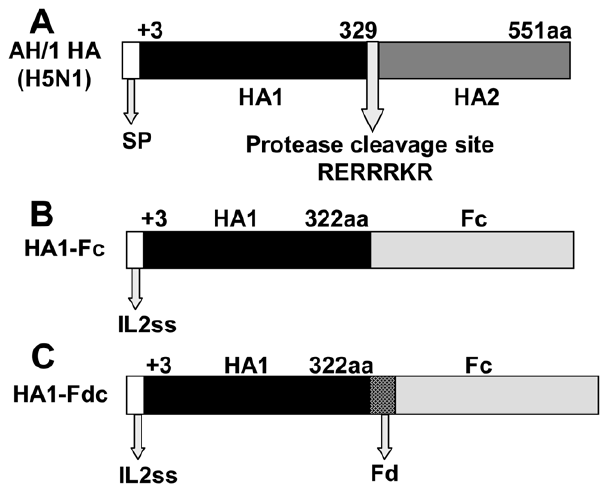
Figure 1. Structure of HA protein of AH/1 and construction of recombinant HA1-Fc and HA1-Fdc proteins. (A) Structure of HA protein of H5N1 AH/1 strain. The HA protein of AH/1 H5N1 virus consists of signal peptide (SP, residues 1–18), HA1 (residues 19–345, corresponding to + 3-329aa) and HA2 (residues 346–567, corresponding to + 330-551aa) fragments spanned by a protease cleavage site RERRRKR between HA1 and HA2. Amino acid 19 of HA1 of AH/1 corresponds to H5N1(A/Vietnam/1203/2004) amino acid + 3 [28]. Schematic structures of recombinant HA1-Fc (B) and HA1-Fdc proteins (C). The original SP of HA of H5N1 virus was replaced by IL2ss signal sequence in the Fc vector, constituting HA1-Fc. HA1-Fdc was constructed by fusing Fd sequence to the C-terminus of HA1, followed by insertion into the Fc vector.